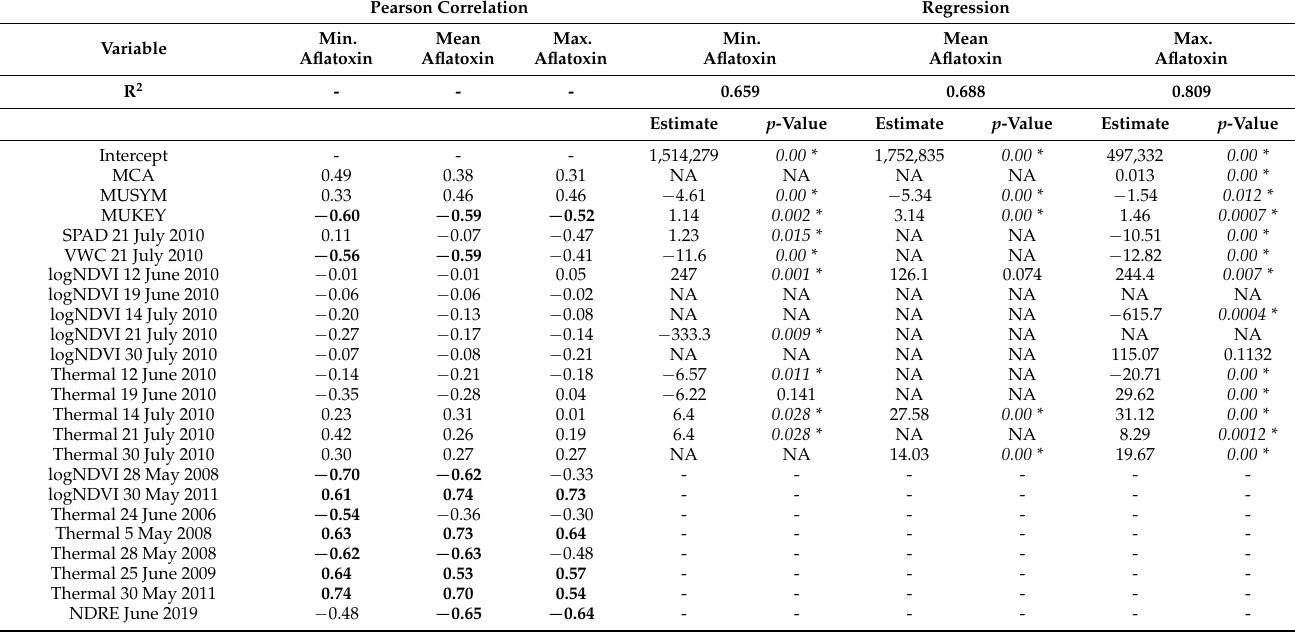
Table 3. Correlation and regression coefficients for Aflatoxin, field and remotely sensed data. Pearson